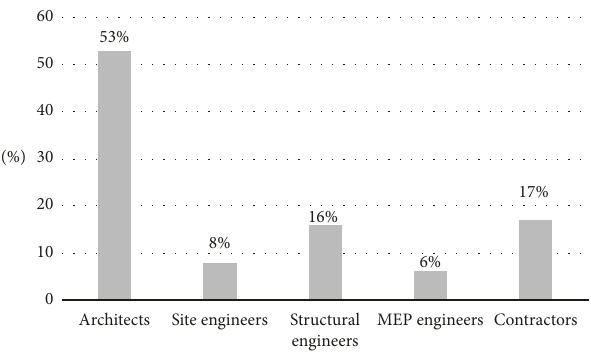
Figure 1: Distribution of the survey participants by the discipline (total N